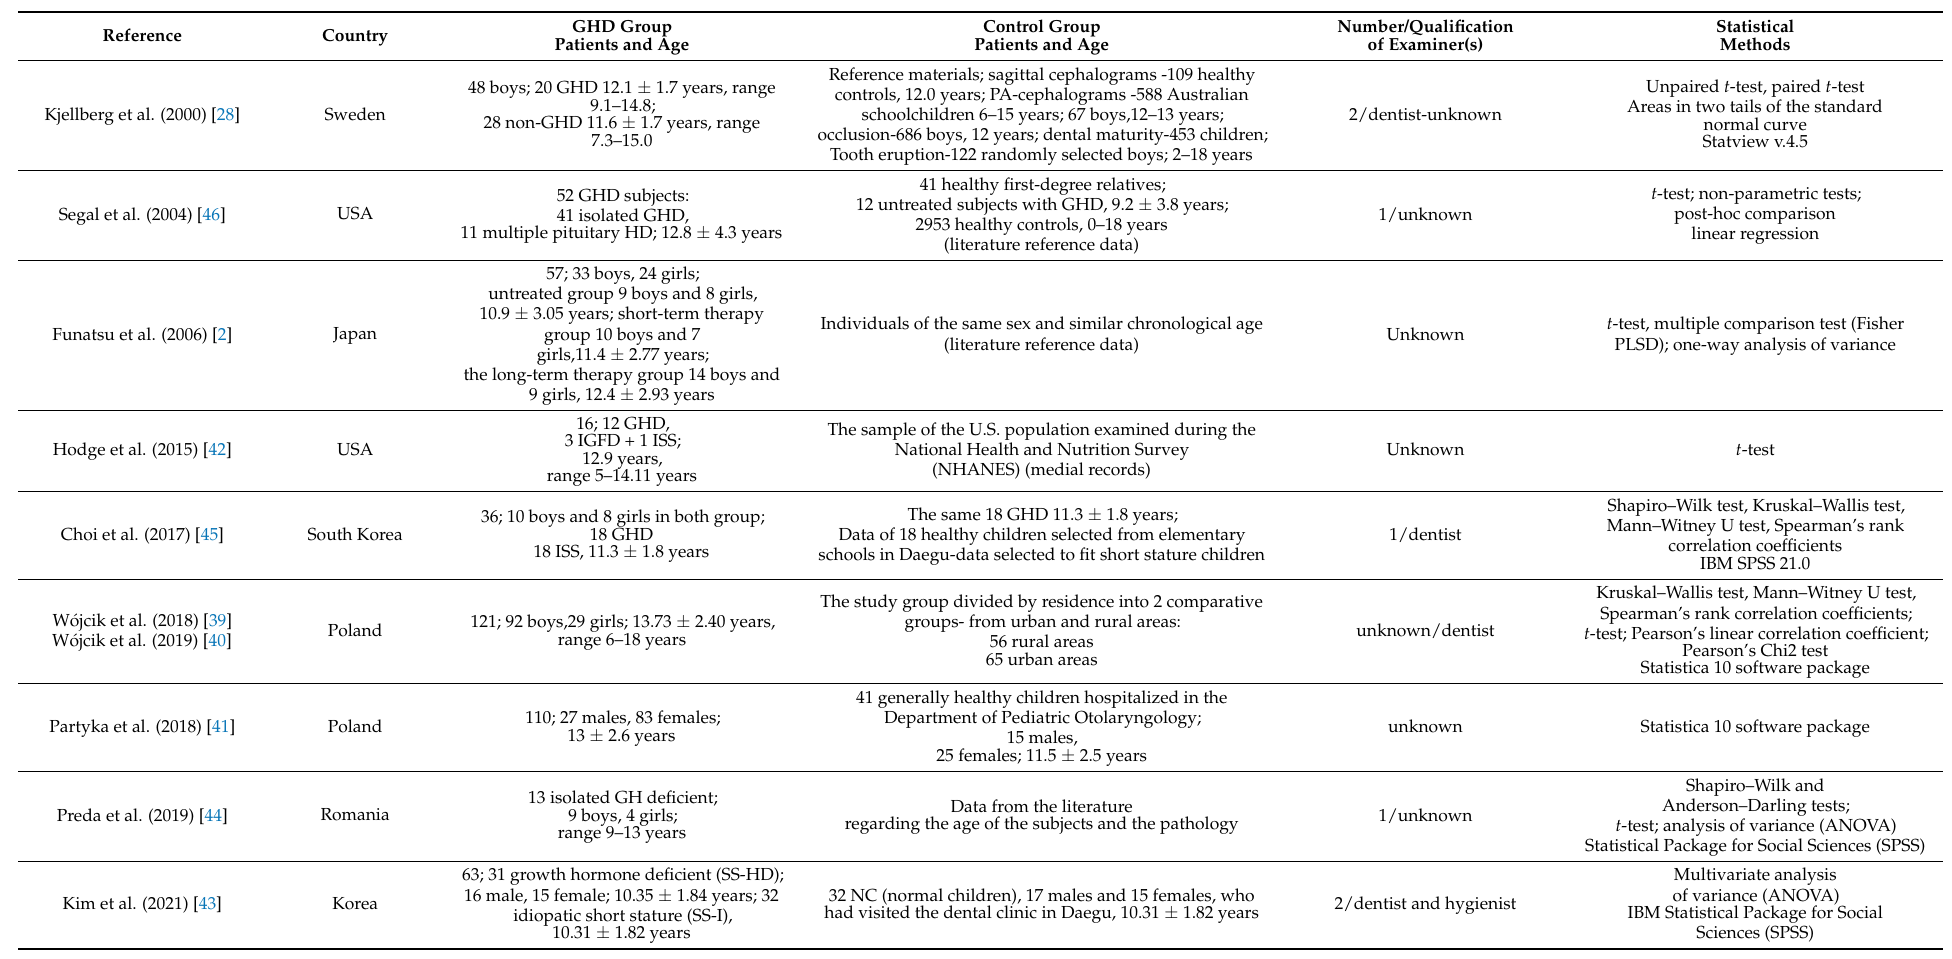
Table 1. Studies included in the systematic